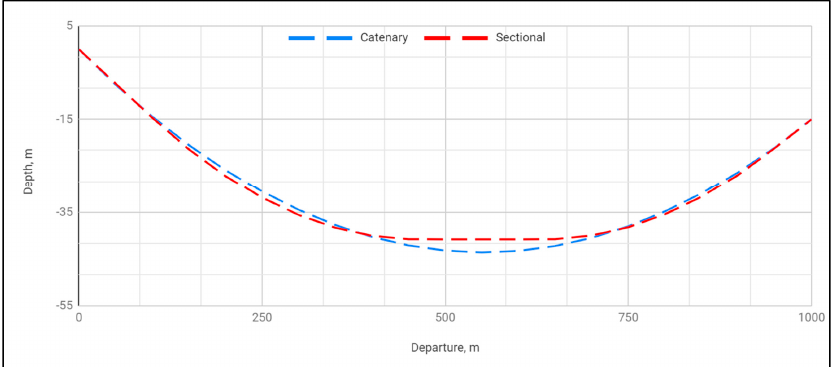
Figure 10. Comparison of the catenary trajectory and the trajectory being a combination of straight and curvilinear sections.